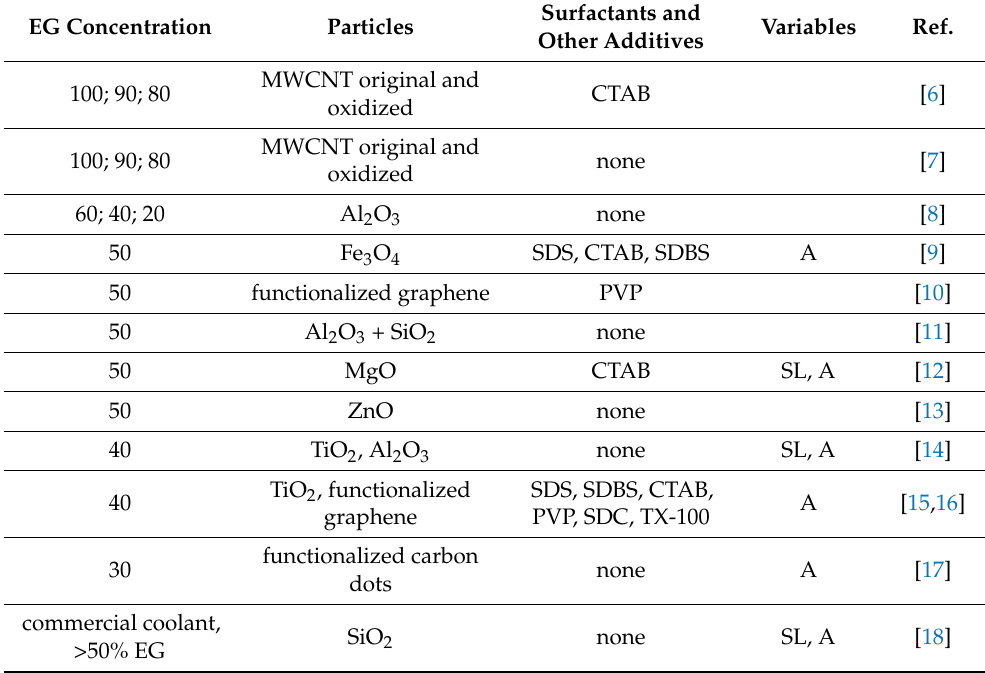
Abbreviations in Table 1: MWCNT multiwall carbon nanotubes; SDS sodium dodecyl sulfate; CTAB cetyltrimethy- lammonium bromide; SDBS sodium dodecylbenzenesulfonate; TX-100 Triton X-100, commercial surfactant; PVP polyvinylpyrrolidone; SDC sodium deoxycholate; SL solid load; A